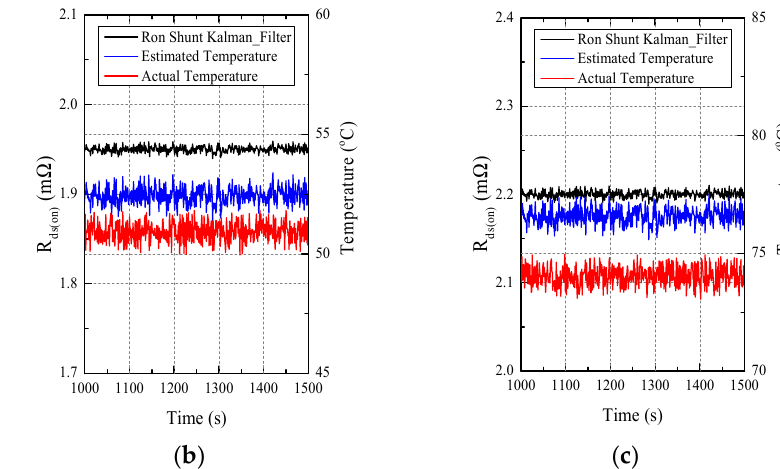
Figure 11. ( a ) Measured temperature, estimated temperature, Rds(on) at 25 °C; ( b ) Measured temperature, estimated temperature, Rds(on) at 50 °C; ( c ) Measured temperature, estimated temperature, Rds(on) at 75 °C. Table 3. Comparison of MOSFET Rds(on) and MOSFET junction temperatures, as shown in Figure 10.